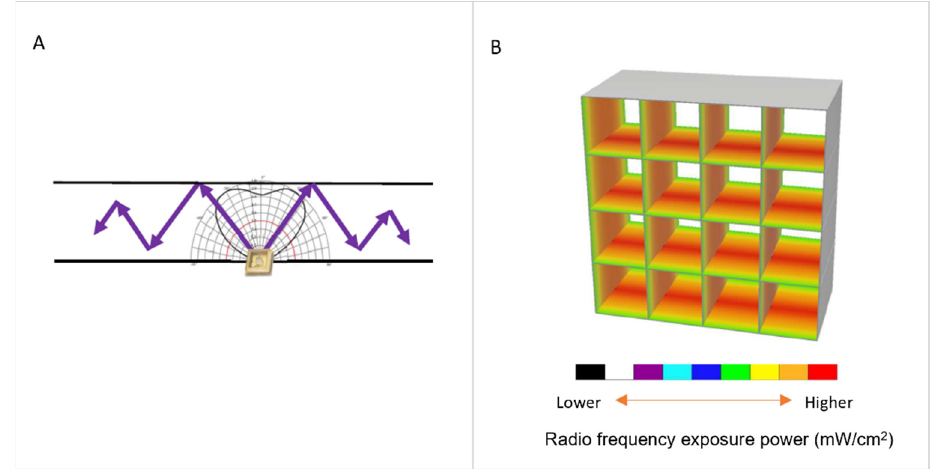
Figure 2. (A ) LED UV-C ray reflections; ( B ) simulation of LED UV-C ray reflections inside sub-ducts. The color scale is representative of the radio frequency exposure power (mW/cm 2 ) and to the refrac- tion.